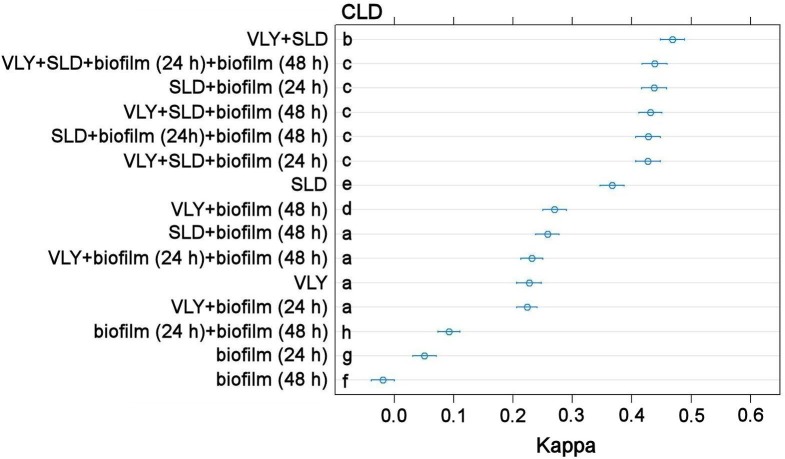
Classification accuracy of numerical features expressed by Cohen kappa values.The models were sorted in descending order according to mean kappa value. Blue circles represent mean kappa values. Error bars indicate 95% CI. VLY, vaginolysin amount; SLD, sialidase activity; biofilm (24 h), biofilm amount after 24 h incubation; biofilm (48 h), biofilm amount after 48 h incubation. The results of pairwise comparisons of each model’s performance using the paired t-test are summarized using the compact letter display (CLD) method.